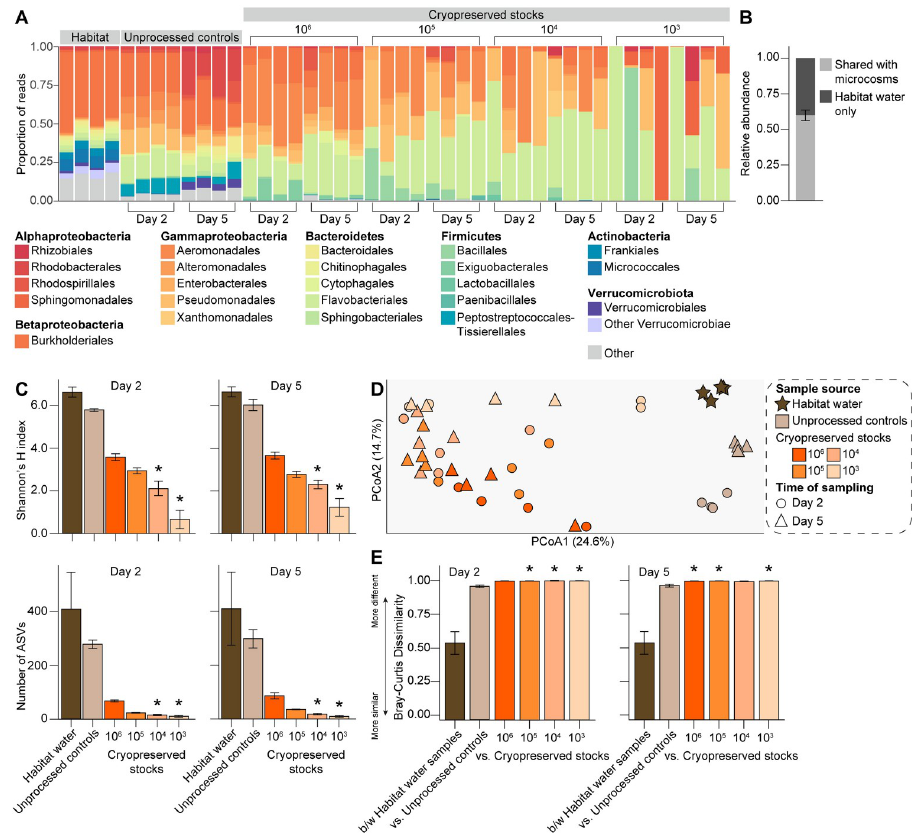
Fig 4. Bacterial diversity in a natural larval habitat and experimental microcosms generated using field-derived microbiota. (A) Relative abundance of bacterial orders in water sampled from: ( i ) a naturally occurring larval mosquito habitat in the field, ( ii ) experimental microcosms containing unprocessed water from the same habitat, or ( iii ) experimental microcosms containing sterile water plus material from a given cryopreserved stock. Each bar presents the proportion of sequencing reads assigned to a given bacterial family. Low abundance orders ( < 1%) are represented by the ‘Other’ category. (B) Average relative abundance of habitat water microbiota shared with experimental microcosms (mean value ± standard error is shown). (C) Alpha diversity of habitat water samples and experimental microcosms, as measured by Shannon’s H index (top) and ASV richness (bottom). Mean values ± standard errors are shown. Asterisks ( * ) indicate significant differences between a given group of experimental microcosm samples relative to habitat water samples (Dunn’s test with Bonferroni correction, P < 0.05). (D) Principal coordinates analysis using the Bray-Curtis dissimilarity index. Symbols are colored by sample source (habitat water, brown; experimental microcosms containing unprocessed water, tan; experimental microcosms containing sterile water plus material from a given cryopreserved stock, orange). Time of sampling (Day 2 or Day 5) of experimental microcosms is designated by symbol shape. (E) Average Bray-Curtis dissimilarity between (b/w) habitat water samples versus between a given habitat water sample and group of experimental microcosm samples. Mean values ± standard errors are shown. Asterisks ( * ) indicate comparisons for which the average dissimilarity between a given habitat water sample and group of experimental microcosm samples was significantly higher than that expected as a result of the microbiota isolation and cryopreservation procedure itself ( i . e ., between habitat water samples) (Dunn’s test with Bonferroni correction, P <